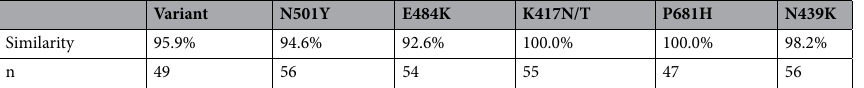
Table 6. Variant and mutation results from the RT-qPCR melting curve assays and the Sanger sequencing for the training cohort were compared how often they had similar results. Samples inconclusive for either the RT-qPCR assay or the Sanger sequencing are